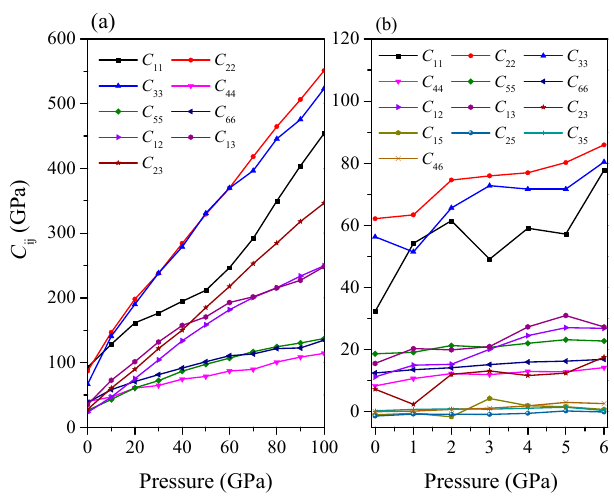
Figure 6. Elastic constants as a function of pressure. ( a ) Pnma -Ca 2 C; ( b ) C 2/ m -Ca 2 C.